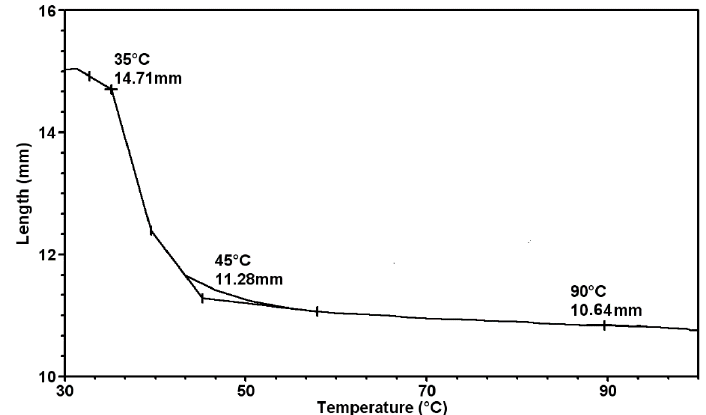
Figure 7. Dependence on the sample length of 100% stretched and stabilized PLLAGLTMC nonwoven fabric versus temperature.